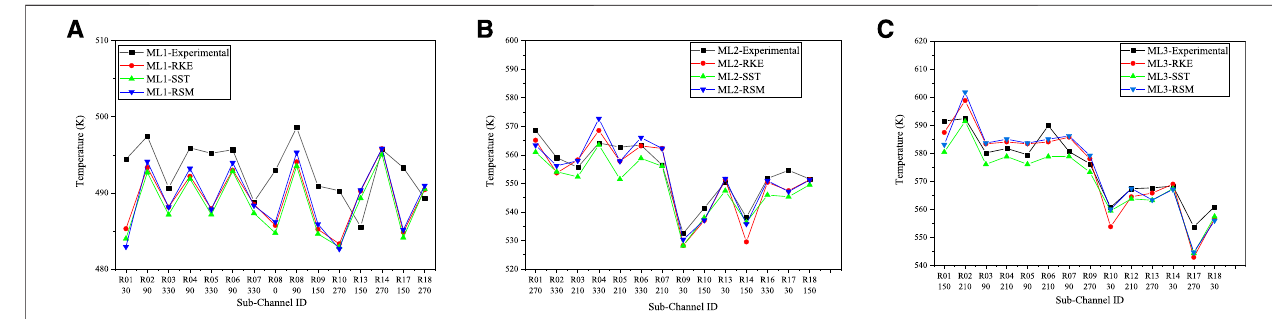
FIGURE 14 | Comparison of the temperature on the rod surfaces. (A) ML1. (B) ML2. (C) ML3.